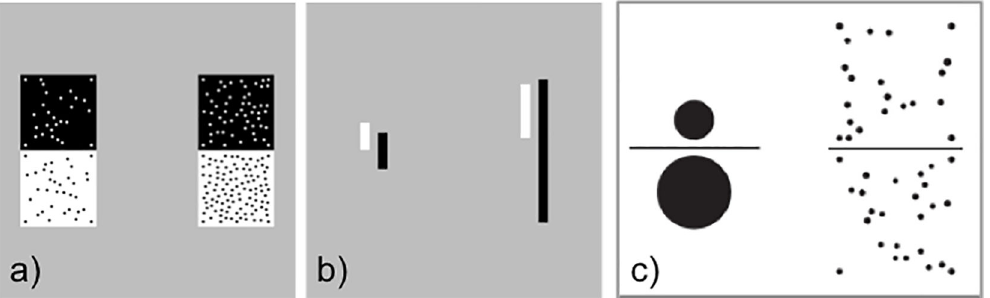
Figure 1. Sample nonsymbolic ratios used in nonsymbolic comparison tasks. Ratios are composed of various type of nonsymbolic quantities, including (a & c) dot arrays, (b) line segments, and (c) circle areas. Note that dot arrays, while countable, are often used in task where the number of dots is high (i.e. > 40) and the time limit is set low (i.e. < 2 seconds) to preclude the possibility of counting. In these instances, dot array numerosity is processed perceptually (for an example, see Matthews & Chesney,